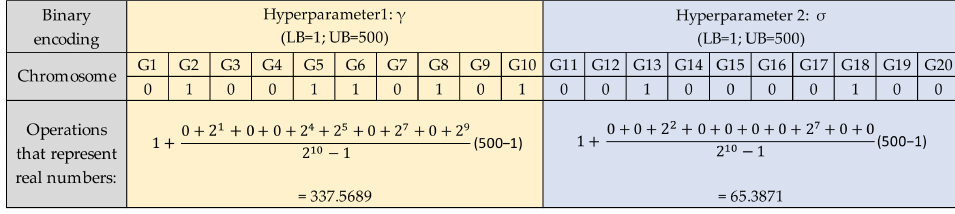
Figure 5. The LSSVR parameter encoding and operation of representing real numbers.